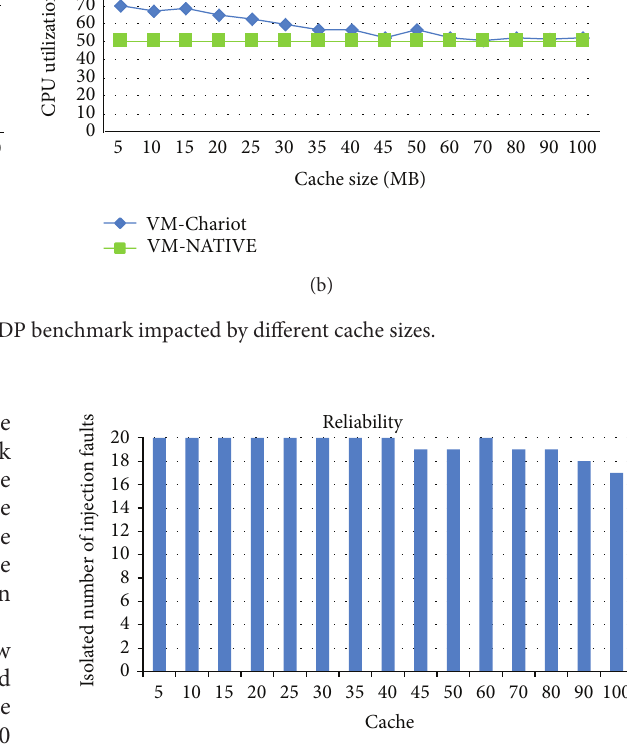
Figure 7: Chariot’s isolation efficiency impacted by different cache sizes 𝐶 of SCDWC